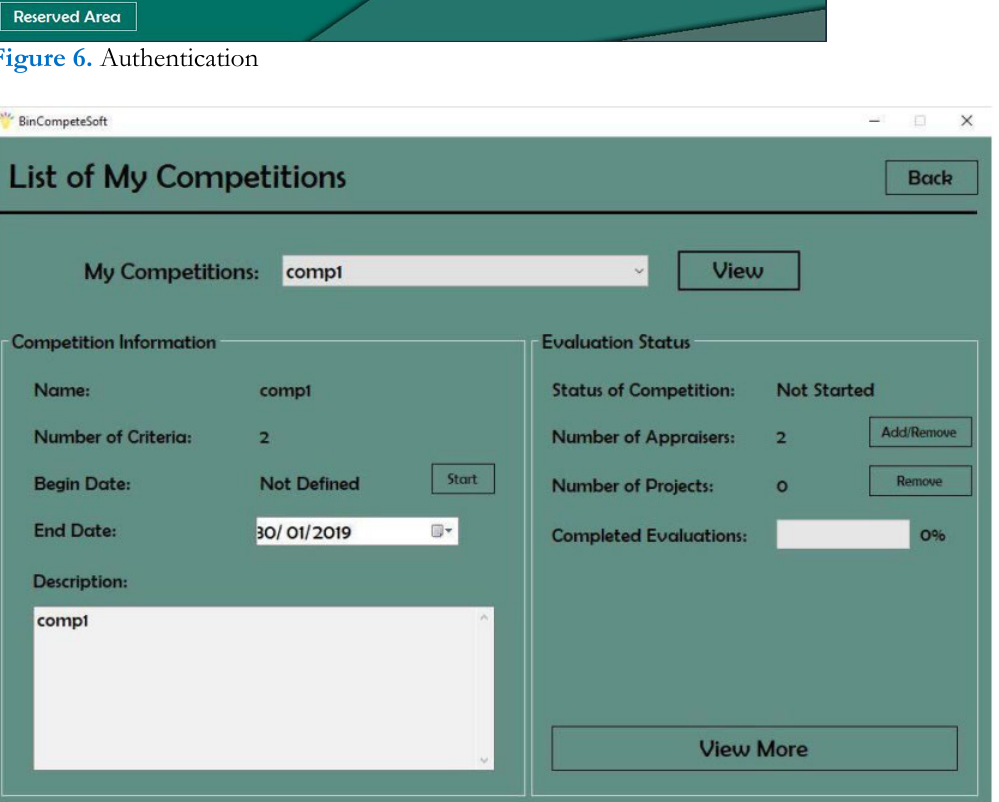
Figure 7. Access to competition’s